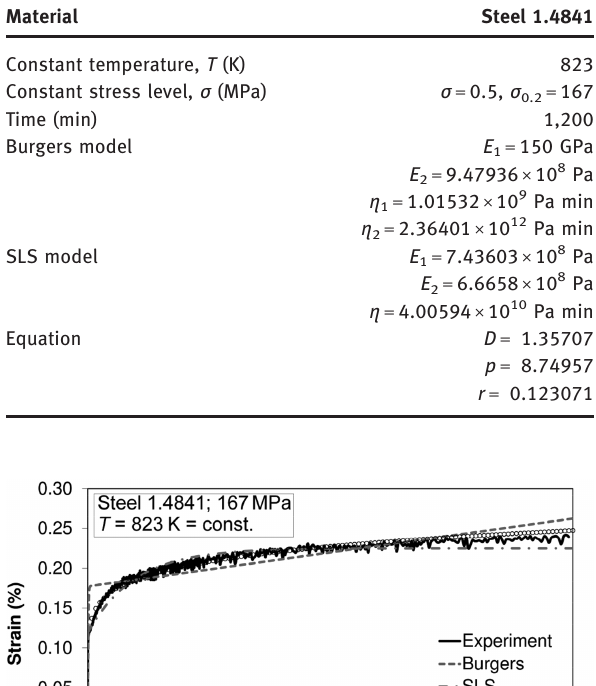
Table 2: Creep modelling data: Steel 1.4841. Material Steel  . 